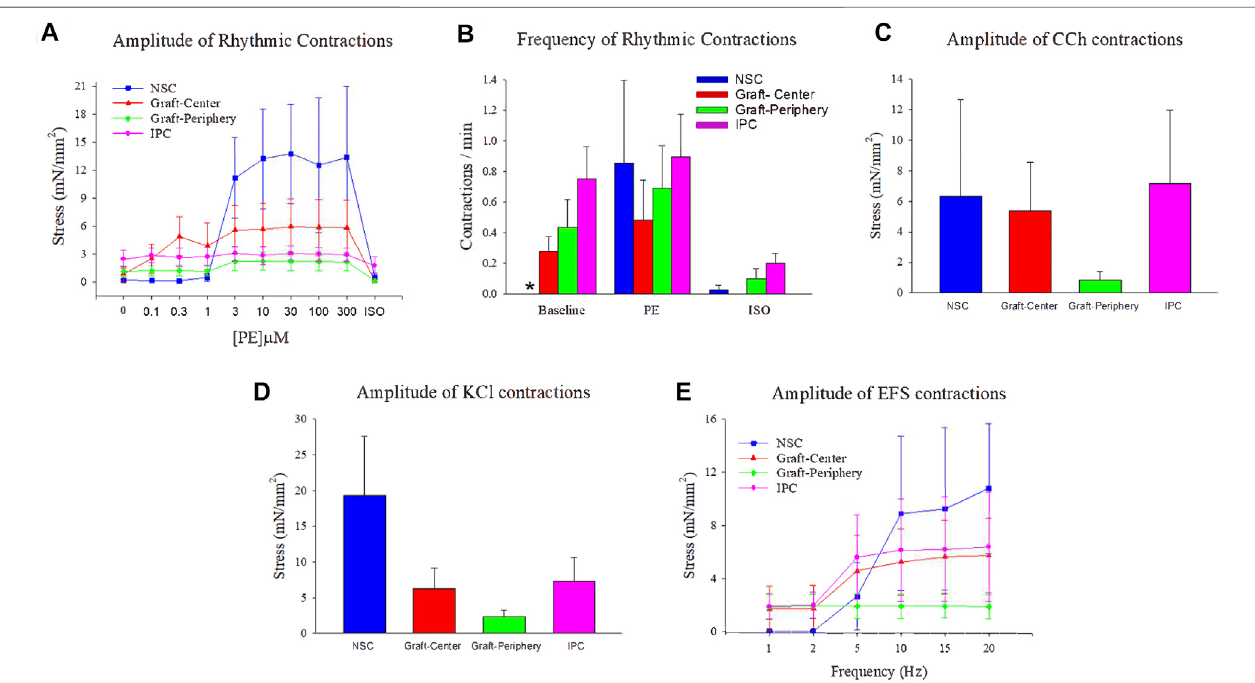
FIGURE 7 | Ex vivo contractile and relaxation responses in experimental groups. Quantitative assessments of contractile and relaxation responses in ureteral muscle tissue from NSC (blue bars and plots), graft-center (red bars and plots), graft-periphery (green bars and plots), and IPC segments at 12 weeks post-op. (A) The amplitude of rhythmic activity was measured before and after administration of increasing concentrations of phenylephrine (PE) followed by isoproterenol (ISO, 10 µM). (B) The frequency of spontaneous activity under baseline conditions, as well as the frequency of evoked activity after PE (300 µM) and (ISO, 10 µM), were compared among each segment. (C – E) The amplitude of ureteral evoked responses induced by (C) carbachol (CCh, 10 µM), (D) KCl (120 mM), and (E) electrical fi eld stimulation (EFS). For all panels, values are displayed as means ± SE with N (cid:1) 4 per data point including specimens from Pigs 1 – 4. Results from all segments were analyzed with Kruskal – Wallis and post hoc Dunn ’ s tests. * p < 0.05 relative to respective IPC levels in (B) . NSC, nonsurgical controls; IPC, internal proximal